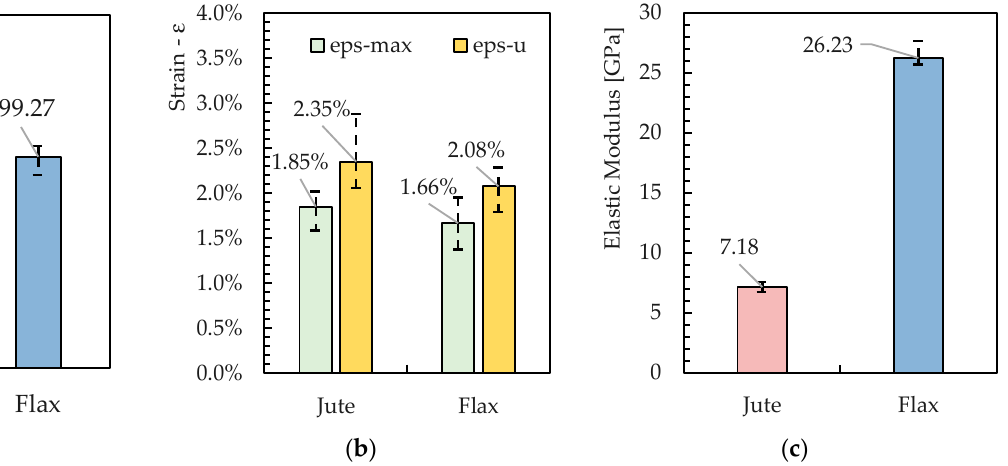
Figure 14. ( a ) Average of the maximum tensile strength, for jute and flax; ( b ) Average of the maximum Young Modulus, for jute and flax; ( c ) Maximum strain and ultimate strain at break for jute and flax.